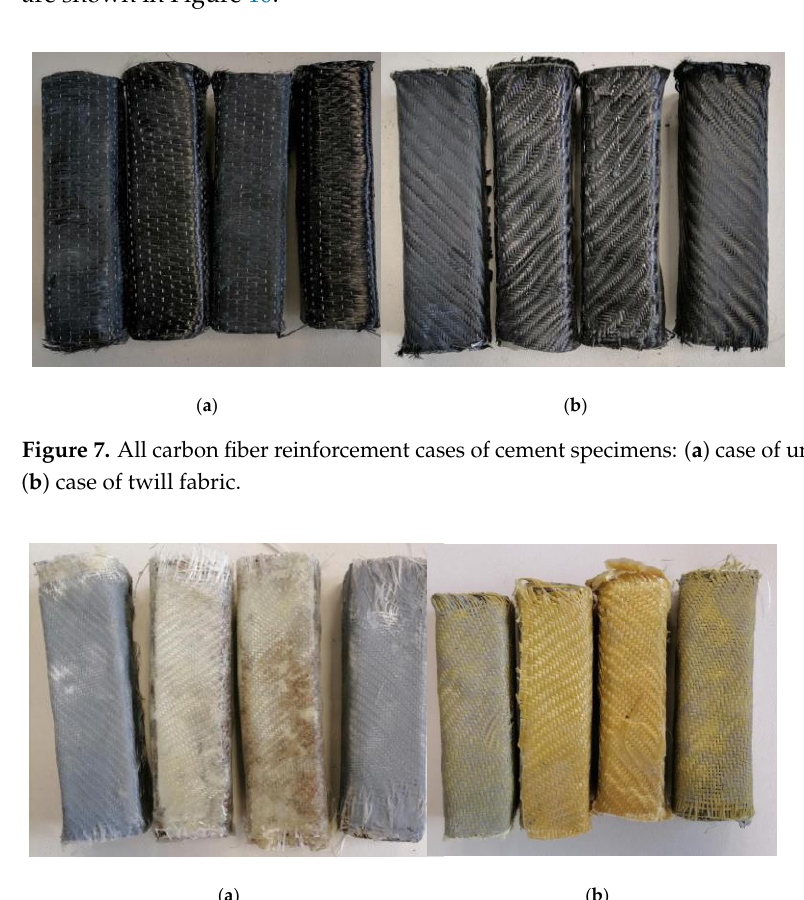
Figure 8. Glass fiber and Kevlar reinforcement cases of cement specimens: ( a ) glass fiber fabric; ( b ) Kevlar fabric.